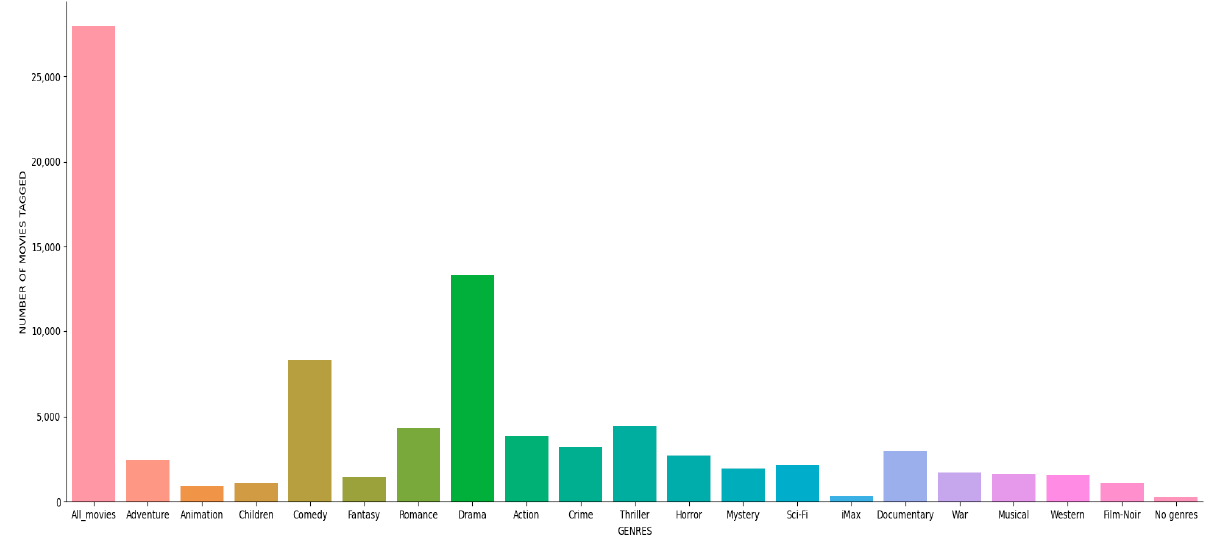
Figure 12. Number of tagged movies in each genre in MovieLens 20M.